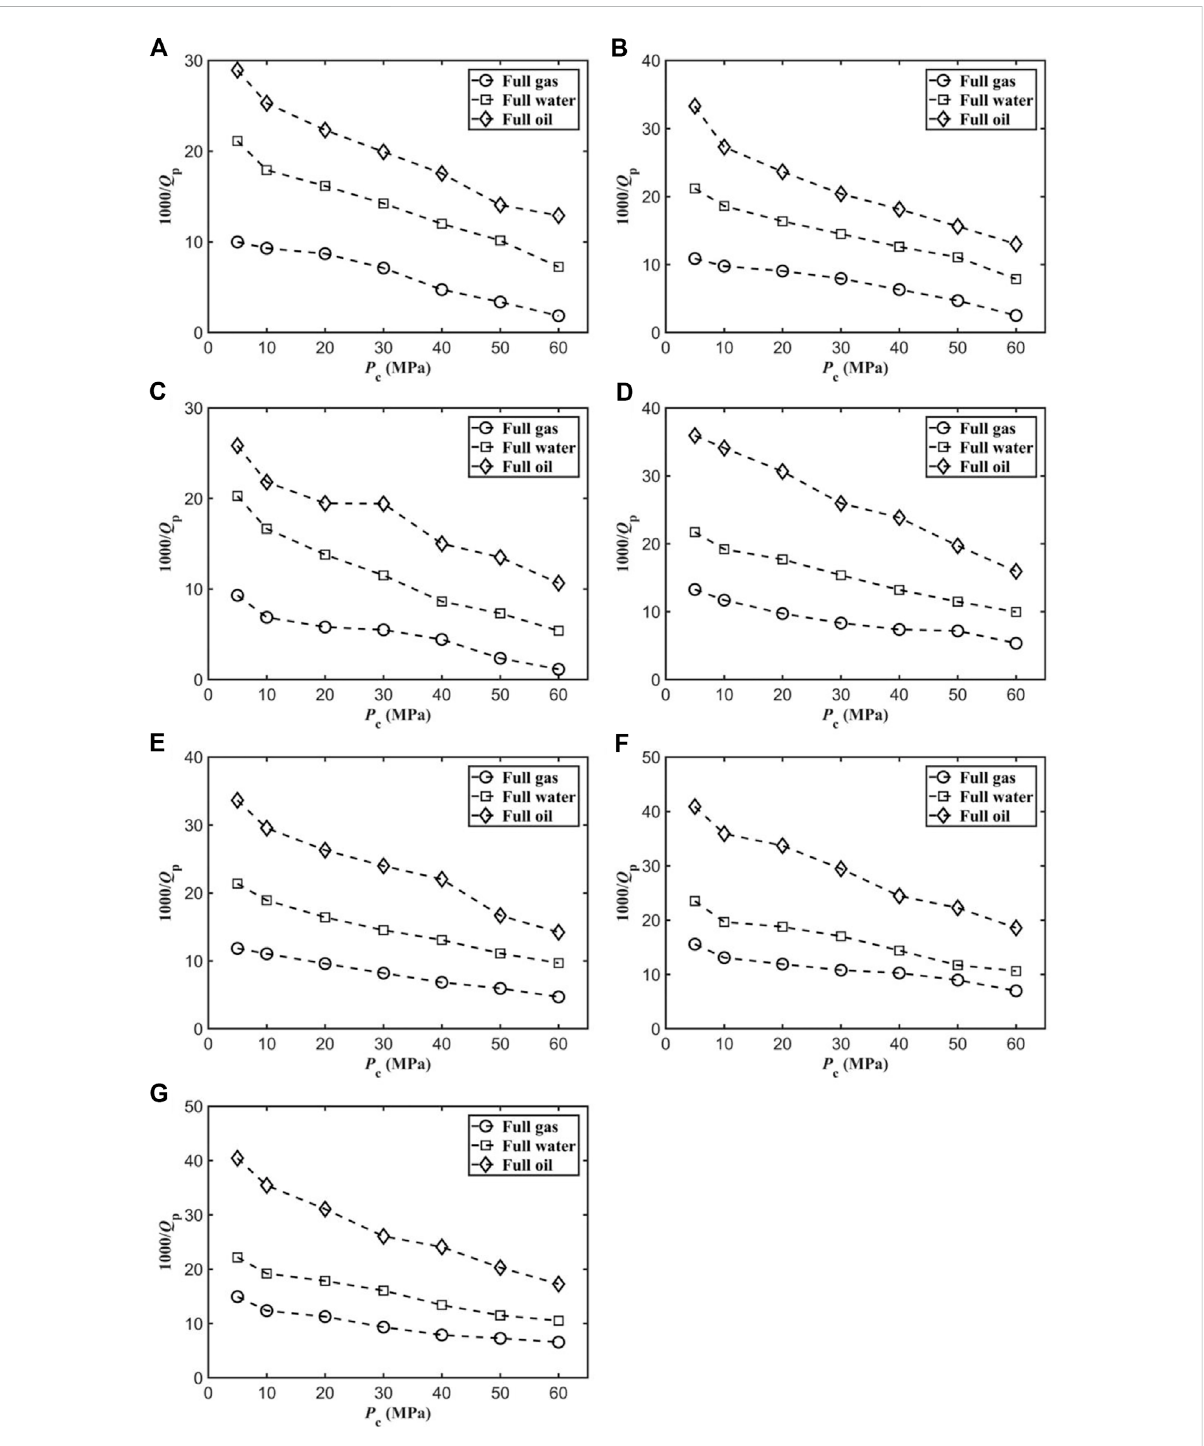
FIGURE 3 P-wave attenuation of samples 1 – 3 (A) , 1 – 12 (B) , 1 – 19 (C) , 1 – 23 (D) , 2 – 7 (E) , 2 – 8 (F) and 2 – 9 (G) as a function of con fi ning